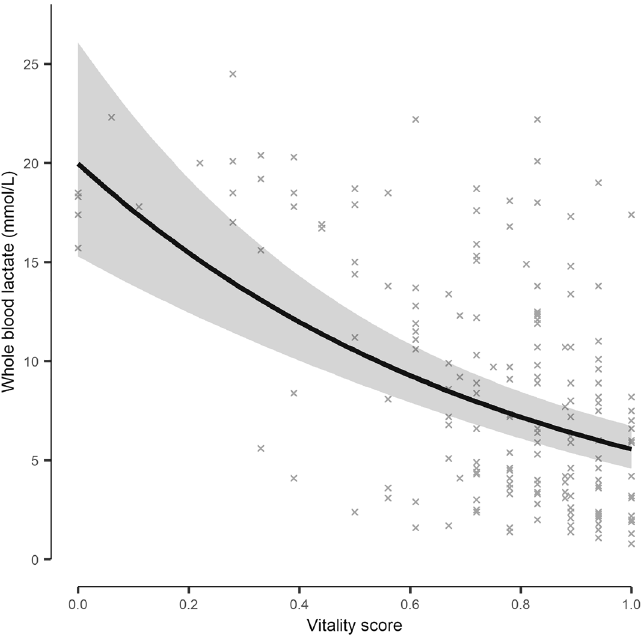
Figure 6. The model derived relationship between vitality scores and blood lactate for Atlantic mackerel ( Scomber scombrus ) during crowding events onboard a commercial purse seine vessel. Fish were collected throughout crowding (after being pumped onboard), assessed for behavioural vitality and then had blood collected from the caudal vasculature. Lactate was quantified using a Lactate Pro 2 point of care device. The shaded area indicates the model derived 95% confidence interval, with the underlying data indicated as points.